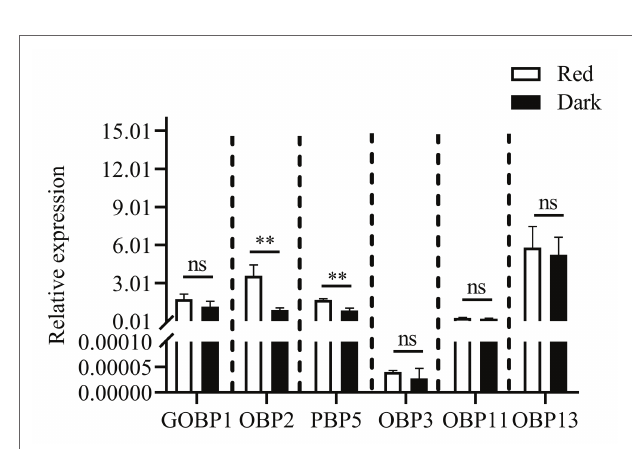
FIGURE 7 | Expression levels of odorant binding protein genes, in antennae of C. punctiferalis males (3-day-old) under red light and dark conditions during scotophase. Data are shown as mean ± SD, from three replicates. Asterisks above columns mean significant differences ( ** p < 0.01, ns: no significant difference), by independent sample t -tests.